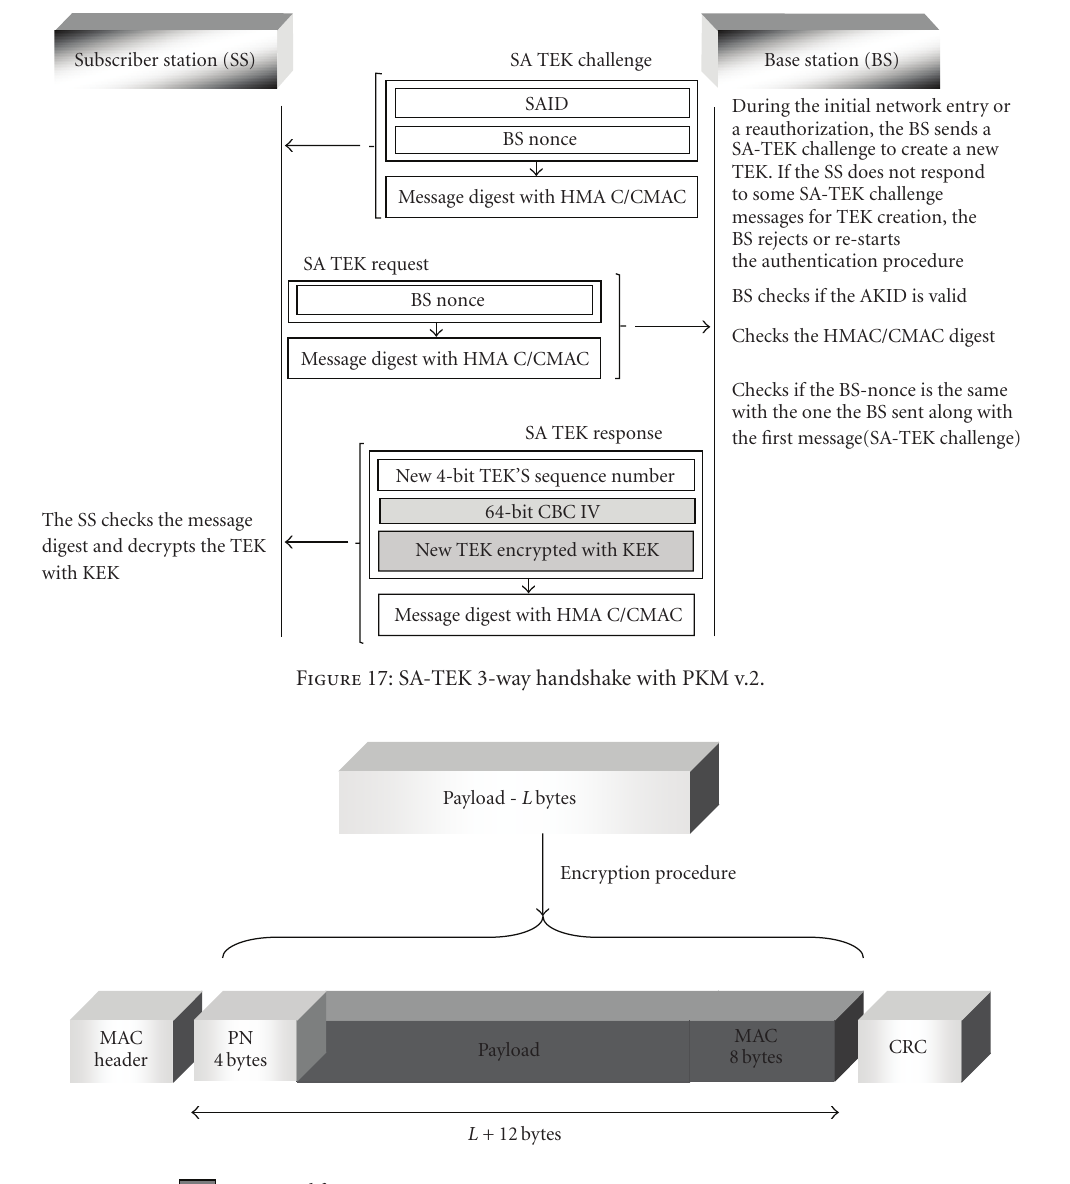
Figure 18: MAC 802.16e encryption